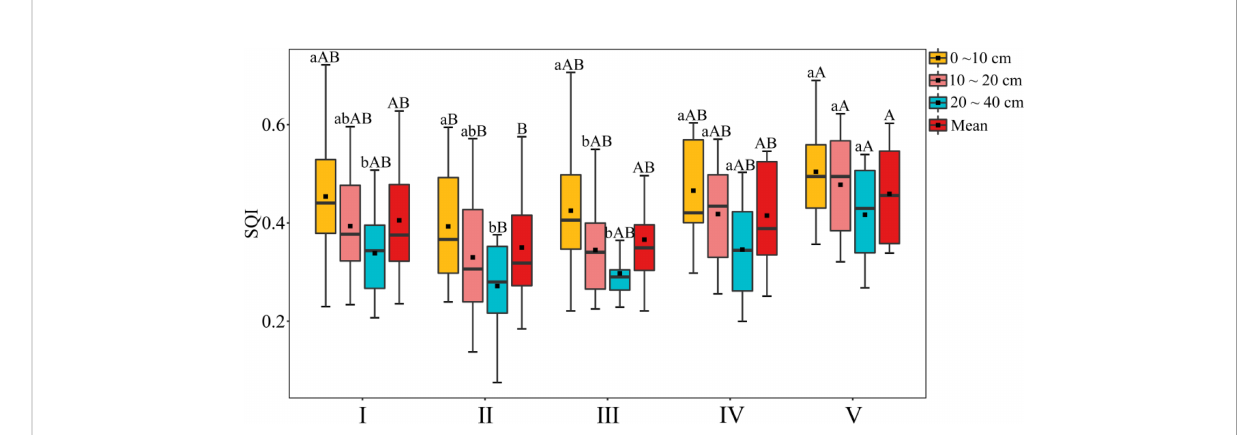
FIGURE 3 Comprehensive evaluation results of soil quality of different forest land types. Above the error line, different lowercase letters indicate signi fi cant differences between different soil layers, and different capital letters indicate that there are signi fi cant differences among different forest land types. I, Broad-leaved forest; II, coniferous forest; III, mixed coniferous and broad-leaved forest; IV, bamboo forest; V, shrub forest. The same